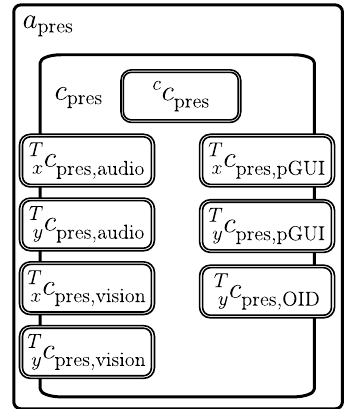
Figure 17. Structure of the agent a prez